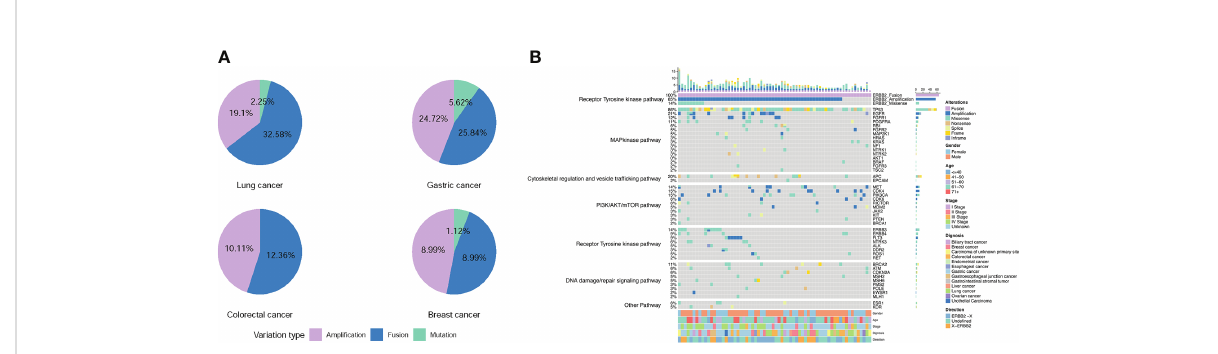
FIGURE 4 Frequency and distribution of ERBB2 variations in solid tumors with ERBB2 fusion. (A) Distribution of ERBB2 variations in three cancer types with ERBB2 fusion, lung cancer, gastric cancer, colorectal cancer, and breast cancer. For each cancer type, the frequency of ERBB2 variations was described as the percentage of all cancer cases analyzed, and the distribution and type of variations were normalized to 100%. (B) Landscape of genomic aberrations of ERBB2 fusion in solid tumors.